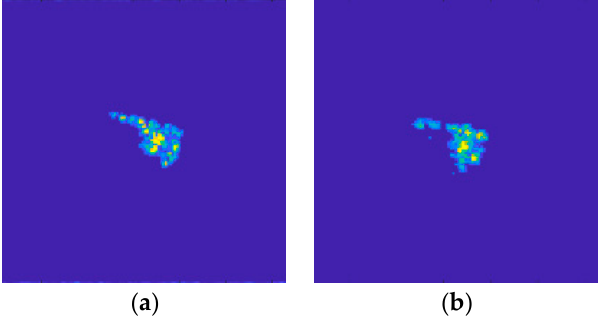
Figure 12. SAR image comparison with large depression angle variation. ( a ) image of T72 at 30° depression angle; and, ( b ) image of ZSU-234 at 17° depression angle.